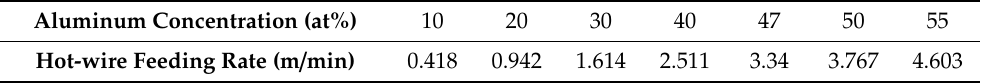
Table 2. Hot-wire feeding rates for varying Al concentrations between 10 at% and 55 at% in Ti–Al. Aluminum Concentration